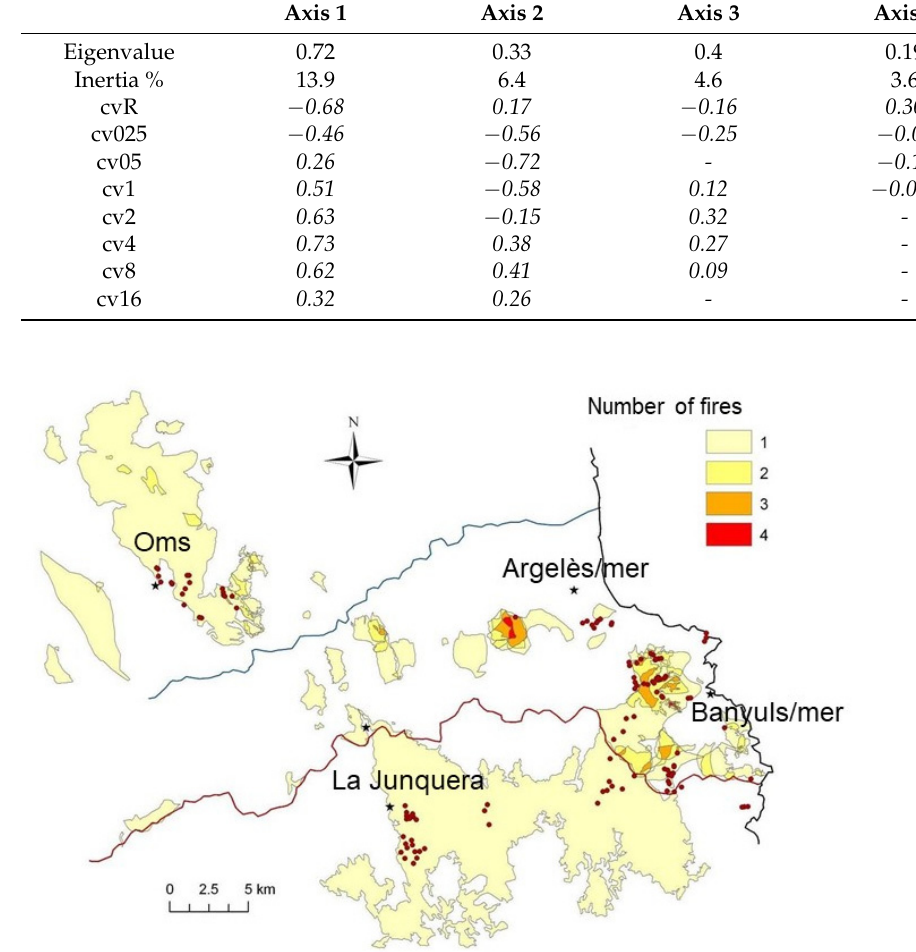
Figure A1. Map of the study area with fire contours corresponding to the 1967–2004 time interval, and some sampling stations. Compiled by Karine Jacquet from various sources [68].